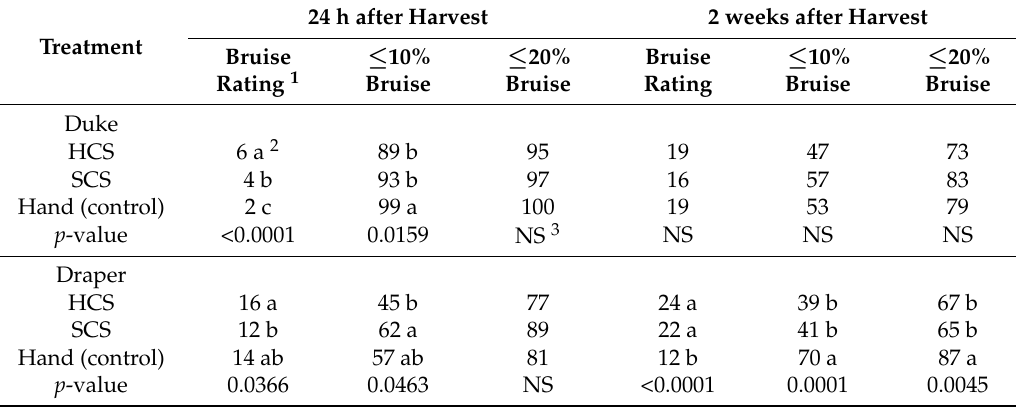
Table 4. Incidence of bruising in ‘Duke’ and ‘Draper’ blueberries 24 h and 2 weeks after machine harvesting using a modified over-the-row harvester prototype with experimental hard and soft catch surfaces (HCS and SCS, respectively) and pneumatic shakers in Oregon. Machine harvested berries were compared to hand-harvested (control) fruit in Oregon in